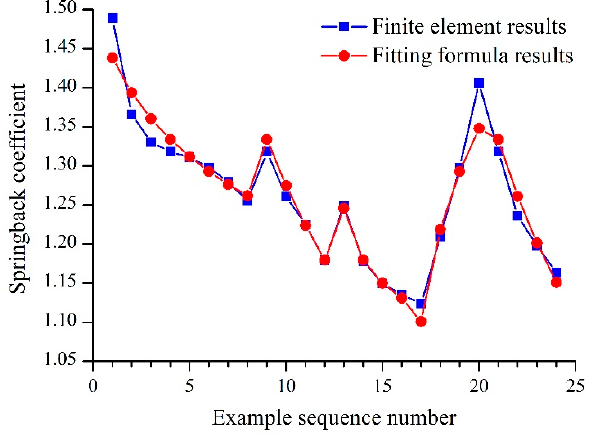
Figure 11. Comparison of fitting formula results with FE results.